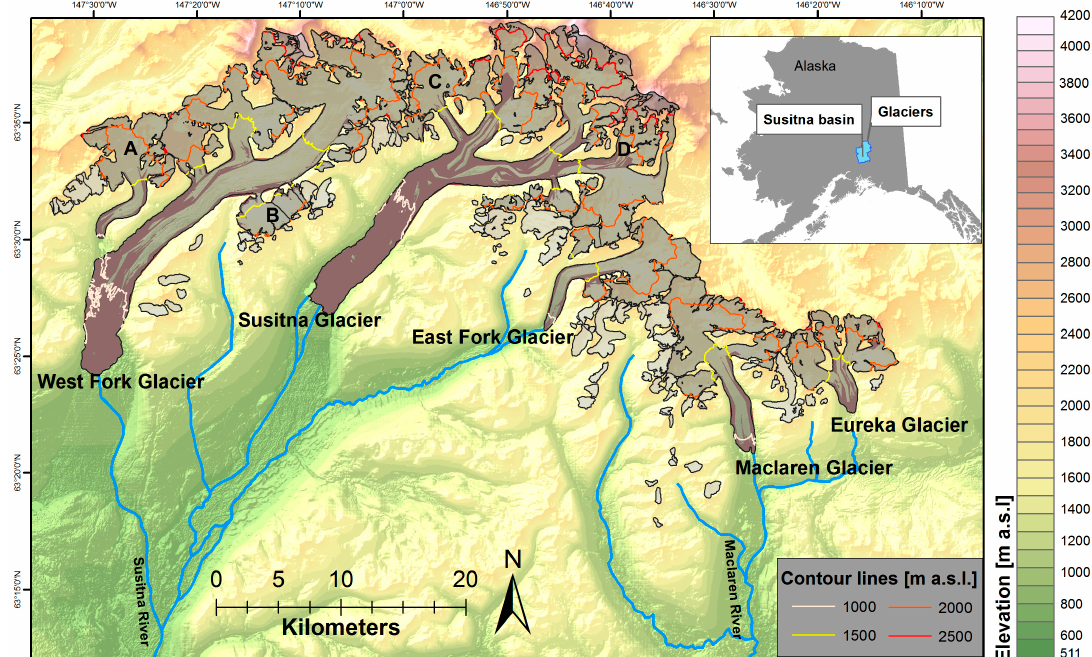
Figure 1. Map of studied glaciers in the Susitna River basin. The five largest named glaciers are marked in dark grey and the remaining glacierized area in light grey. Debris covered ice is shown in brown. Glacier outlines and debris cover extent are derived from 2010 Landsat imagery. Tributaries discussed in the text are labeled with letters. Contour lines for altitudes of 1000, 1500, 2000, and 2500 m a.s.l. are added. The irregular course of the 1000 m contour on West Fork and Susitna Glacier reflects the hummocky surface topography caused by debris cover.